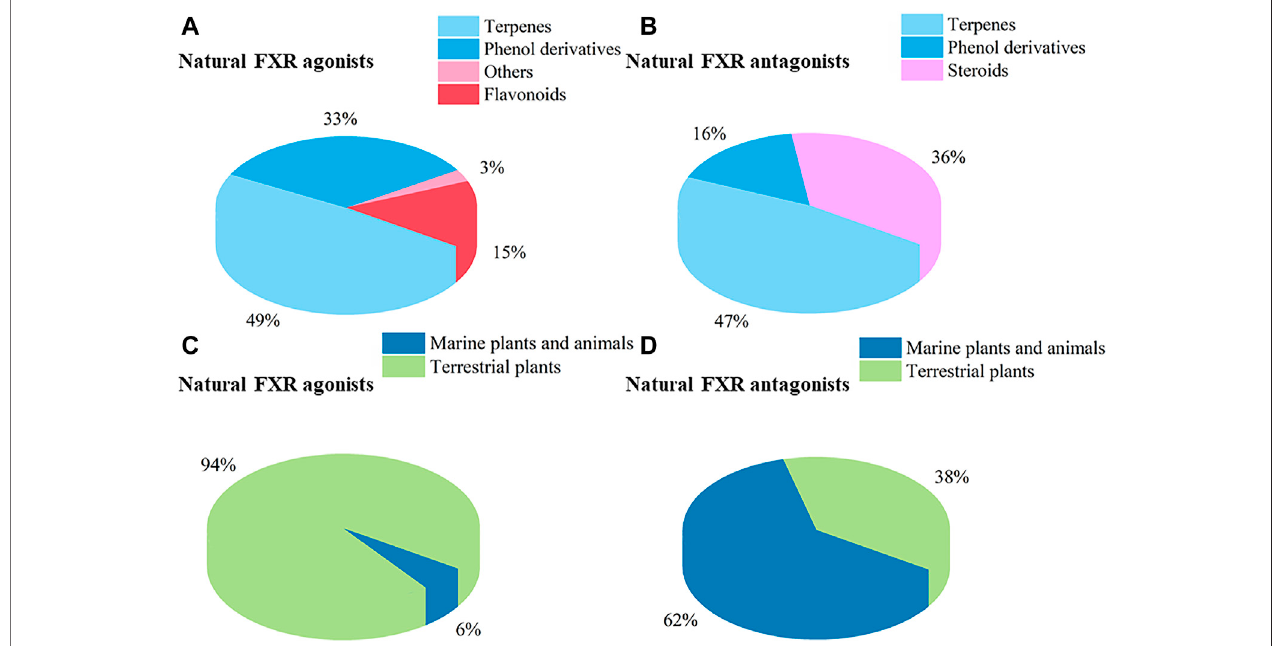
FIGURE 5 | Chemical types (A, B) and resources (C, D) of natural-derived FXR agonists and antagonists.